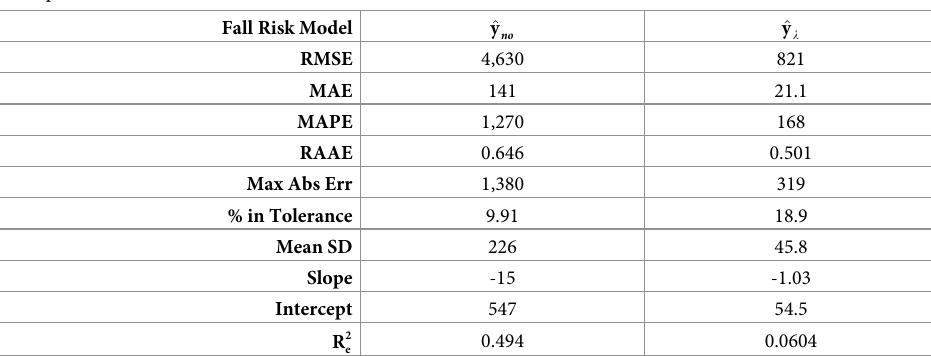
Table 8. Summary statistics for both fall risk models using data from the validation gaits. ^ y indicates the model no that excludes the long-term Lyapunov exponents, and ^ y indicates that the model includes this data. The values are l over all of the trials. The root mean squared error (RMSE), mean absolute error (MAE), mean absolute percentage error (MAPE), relative average absolute error (RAAE), and maximum absolute error (Max Abs Err) are given. The % in Tolerance indicates the percentage of these trials in which the predicted value was within the true ln(MFPT) ± 3.3. The mean SD are the mean of the standard deviation data for each validation condition. The slope, intercept, and R 2 e are each from a linear fit of the ln(MFPT) for all validation trials (Eq 15). Values of 1, 0, and 1, respectively, would indi- cate a perfect fit. Fall Risk